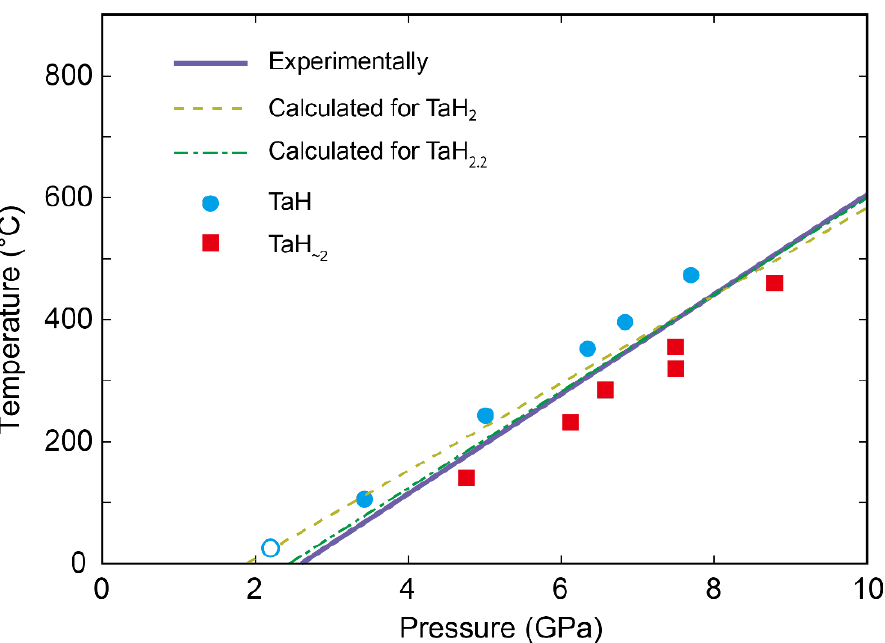
Figure 3. Pressure – temperature phase diagram of Ta – H system. Squares and circles denote the pressure – temperature conditions where the formation of hcp TaH ~2 and distorted bcc TaH detected during heating and cooling runs, respectively, were observed. The solid line indicates the experimentally determined phase boundary between distorted bcc TaH and hcp TaH ~2 . Dotted and dashed lines depict calculated phase boundaries based on Clausius – Clapeyron equation for dehydrogenation reaction of TaH 2.0 and TaH 2.2 , respectively. Open circle indicates the previously reported pressure – temperature conditions where TaH 2 transformed into TaH [10].